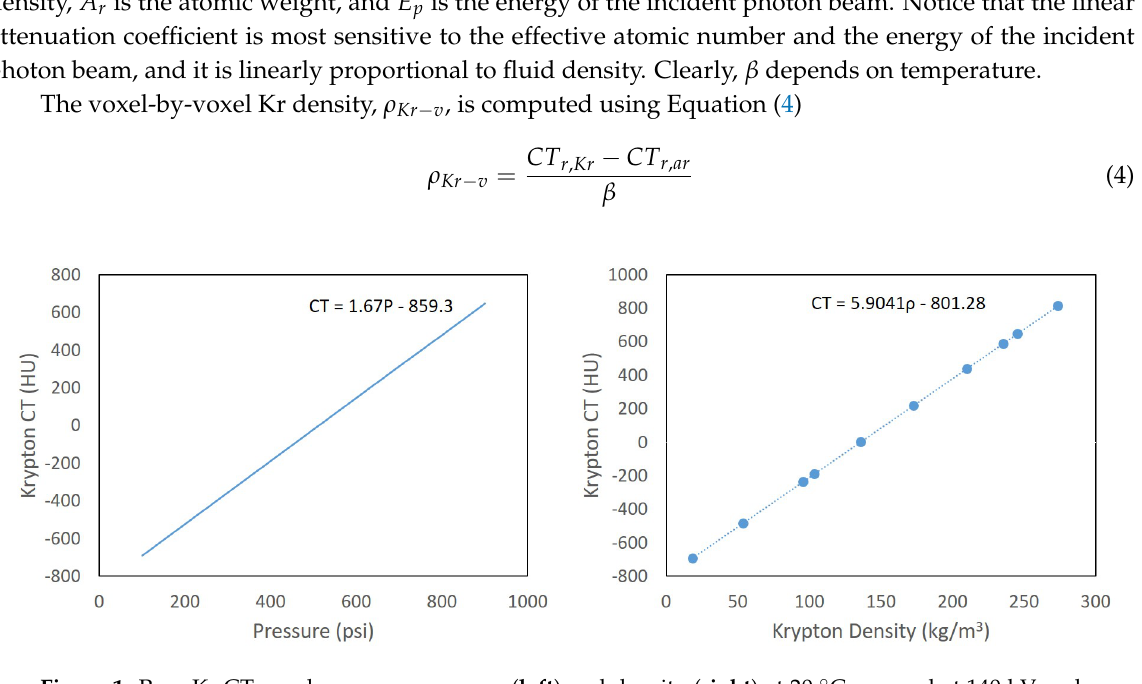
Figure 1. Pure Kr CT number versus pressure ( left ) and density ( right ) at 20 ◦ C scanned at 140 kV and 120 mA. CT number versus krypton pressure correlation was acquired from Aljamaan et al. (2017) [30].